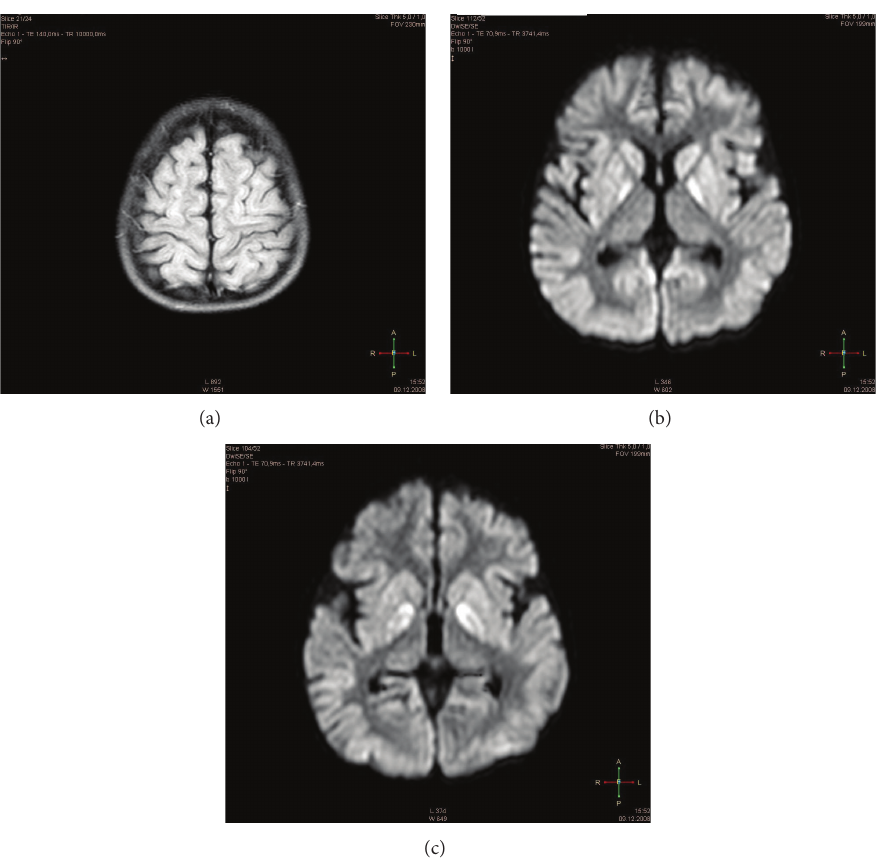
Figure 1: (a), (b), and (c) Brain MRI of the patient (L.B.) 2 weeks after cardiac arrest. Note signs of severe global ischemia in cortical structures as evidenced by (a) signal hyperintensity of gyri in almost entire cortex (FLAIR sequences) and basal ganglia (b), including caudate nucleus, pallidum, and putamen (c) (FLAIR DWI sequences with contrast